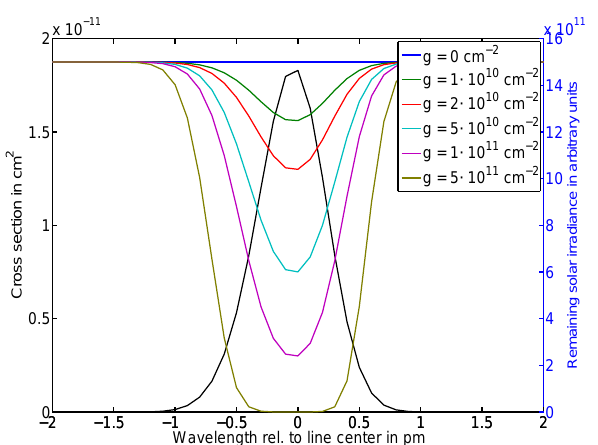
Fig. 17. Calculation of the wavelength-specific emissivity for the Mg 285.2nm line as a function of wavelength difference from the center of line. It is the product of the solar irradiance, attenuated along the line from Sun and the line-of-sight, and the absorption cross section (both shown in Fig. 16). To obtain the emissivity of the spectral line, this spectrum has to be integrated over all wavelengths. For strong absorption the light comes mainly from the edges of the line instead of the line center. This reduces the effective cross sec- tion for the total integrated